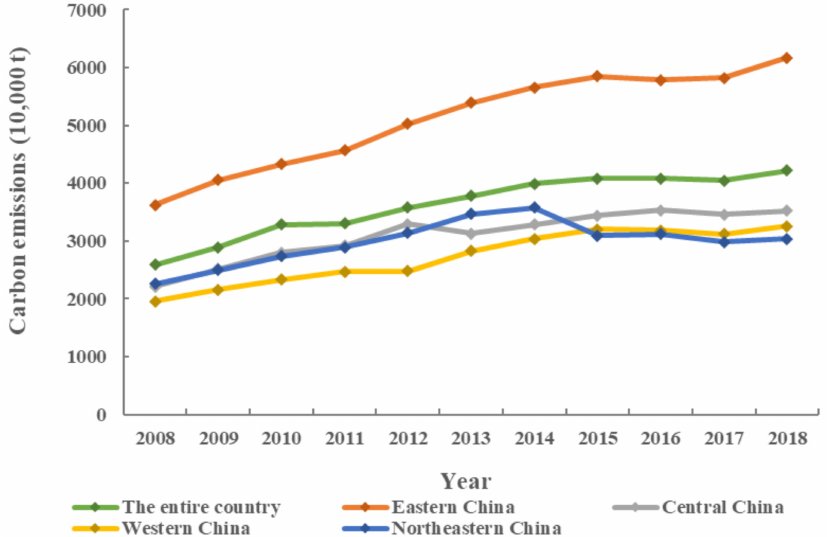
Figure 2. The average values of UCEs in China and its four regions between 2008 and